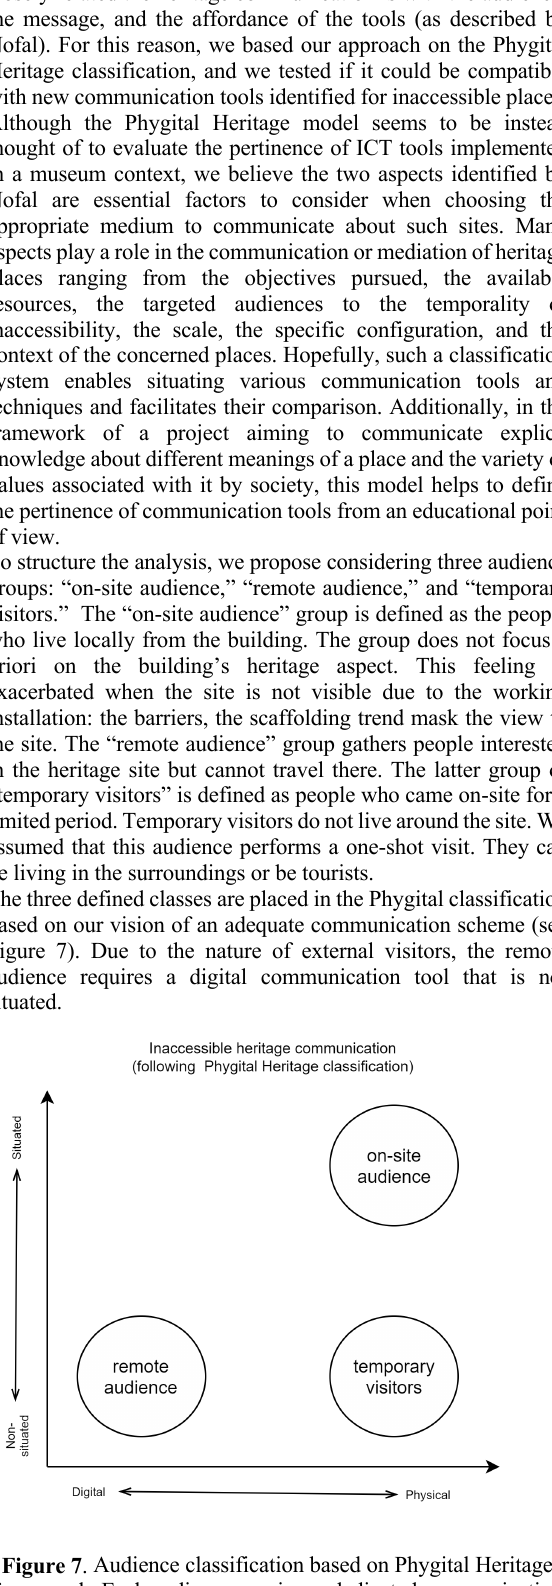
Figure 7 . Audience classification based on Phygital Heritage framework. Each audience requires a dedicated communication